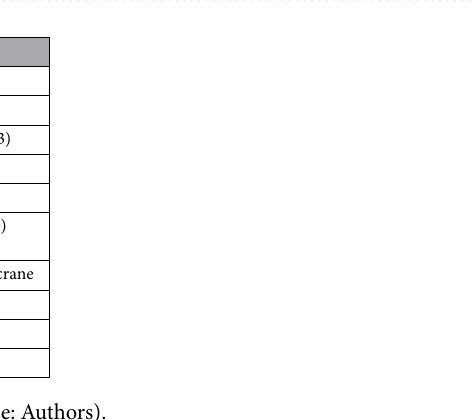
Figure 5. The idea of Emergency Fueling Unit (EFU). 1. stream injector with fuel fumigation, 2. fuel collector, 3. air collector, 4. air compressor, 5. pressurised fuel tank, 6. auxiliary air reservoir, 7. main fuel valve, 8. shut-off valve, 9. bypass, 10. intake valve, 11. exhaust valve, 12. the injector. (Source: Authors).